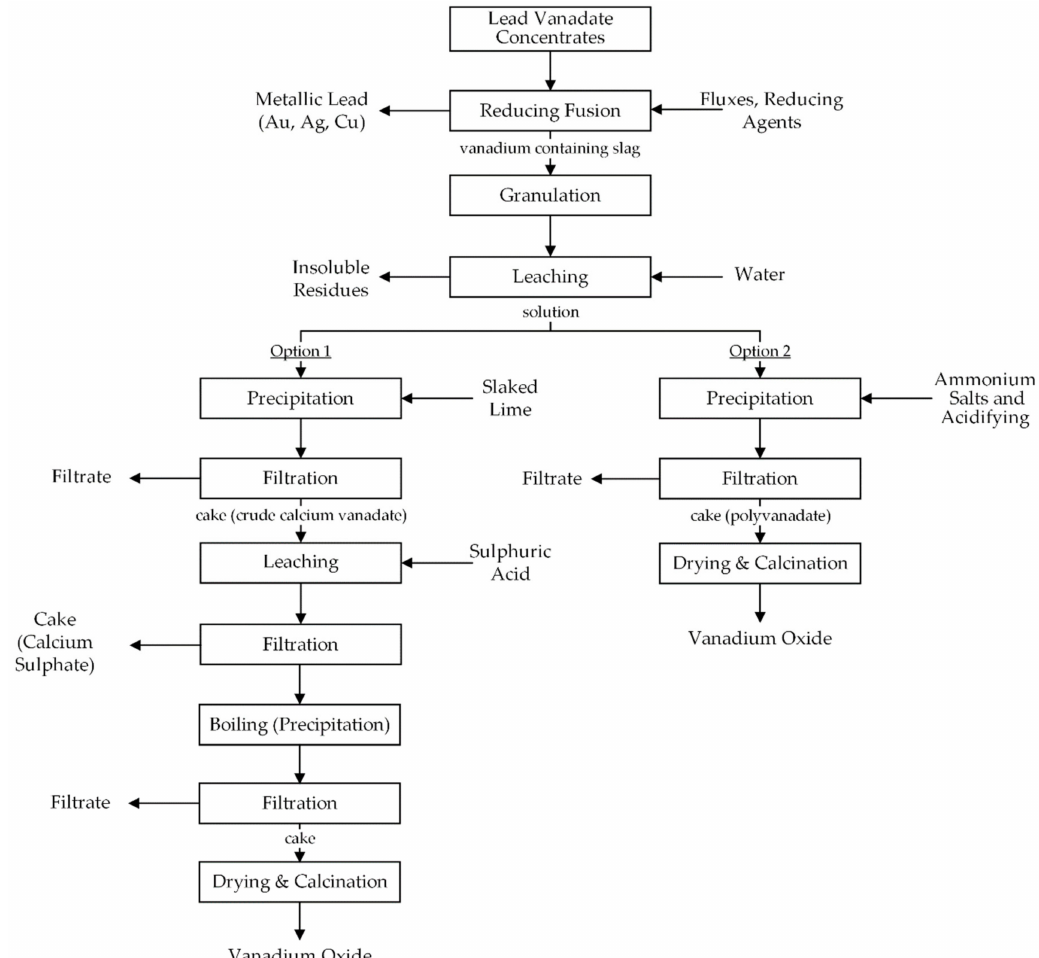
Figure 6. Simplified metallurgical treatment flowsheet of lead-vanadium